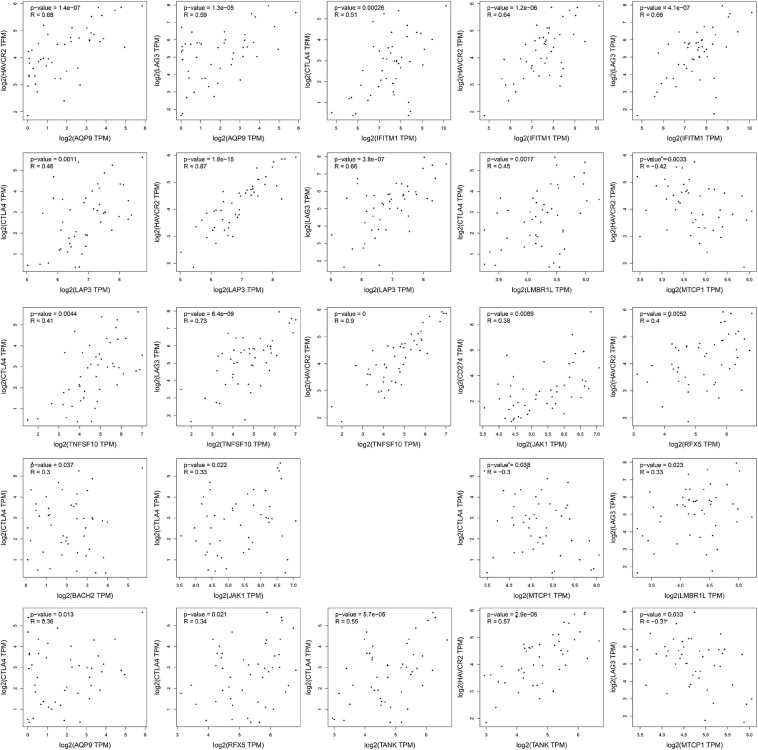
The results of correlation analysis. The expression data of all gene had taken the logarithmic value of 2. The statistically insignificant experimental results were not shown.